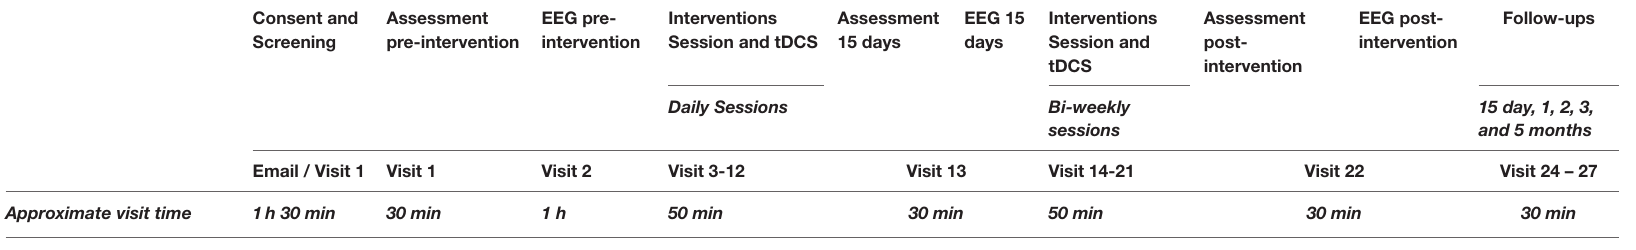
TABLE 1 | Summary and timeline of